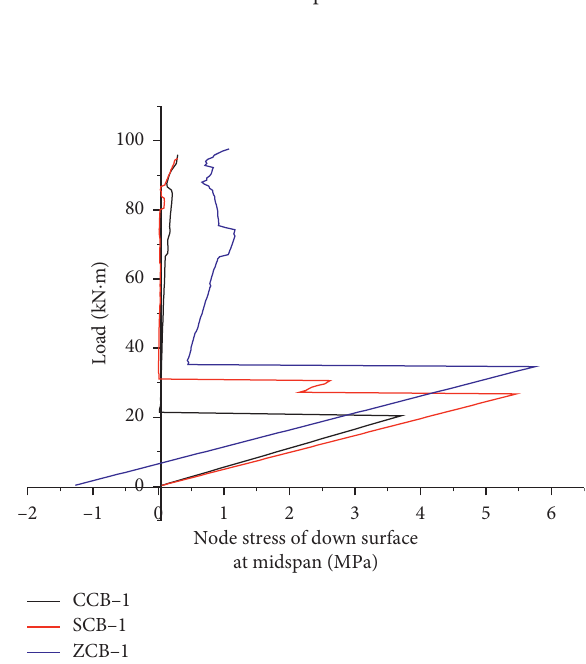
Figure 26: Stress history of the middle node on the bottom surface of the test